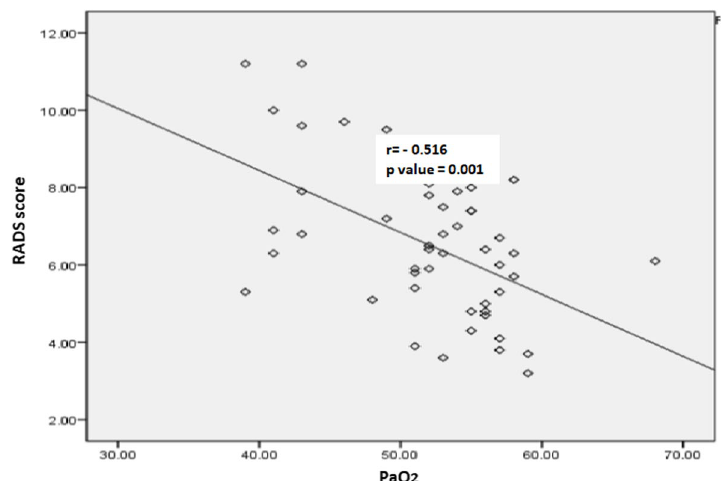
Fig. 5 Correlation between baseline PaO2 and radiologist score